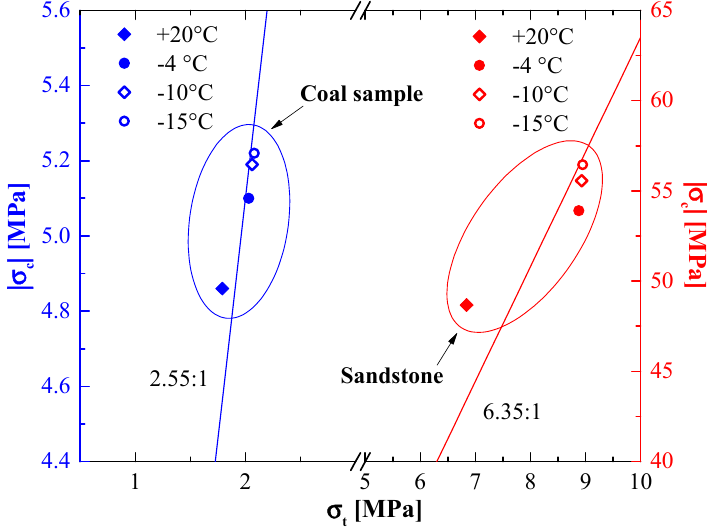
Figure 5. Plot of yield stress in compression versus ultimate tensile stress for performed tests at various